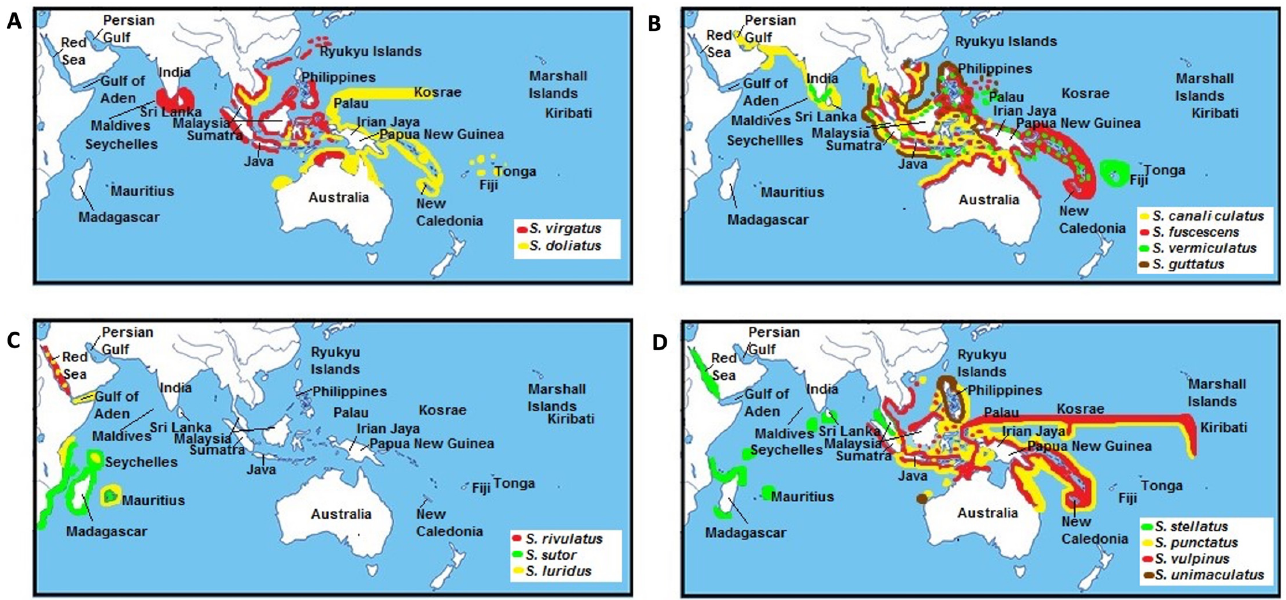
Figure 7. Distribution ranges of siganid sister species across the Indo-Pacific region adapted from Woodland [1]. Distribution regions for ( A ) S. virgatus and S.doliatus , ( B ) S. canaliculatus , S. fuscescens , S. vermicualtus , and S. guttatus , ( C ) S. rivulatus , S. sutor , and S. luridus , ( D ) S. stellatus , S. punctatus , S. vulpinus , and S. unimaculatus .